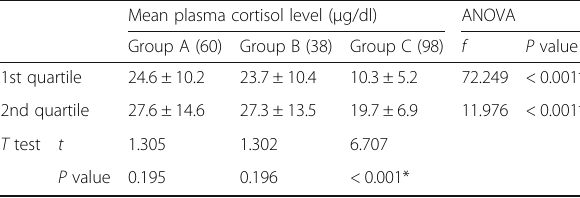
Table 5 Mean plasma cortisol level in stroke patients and control group